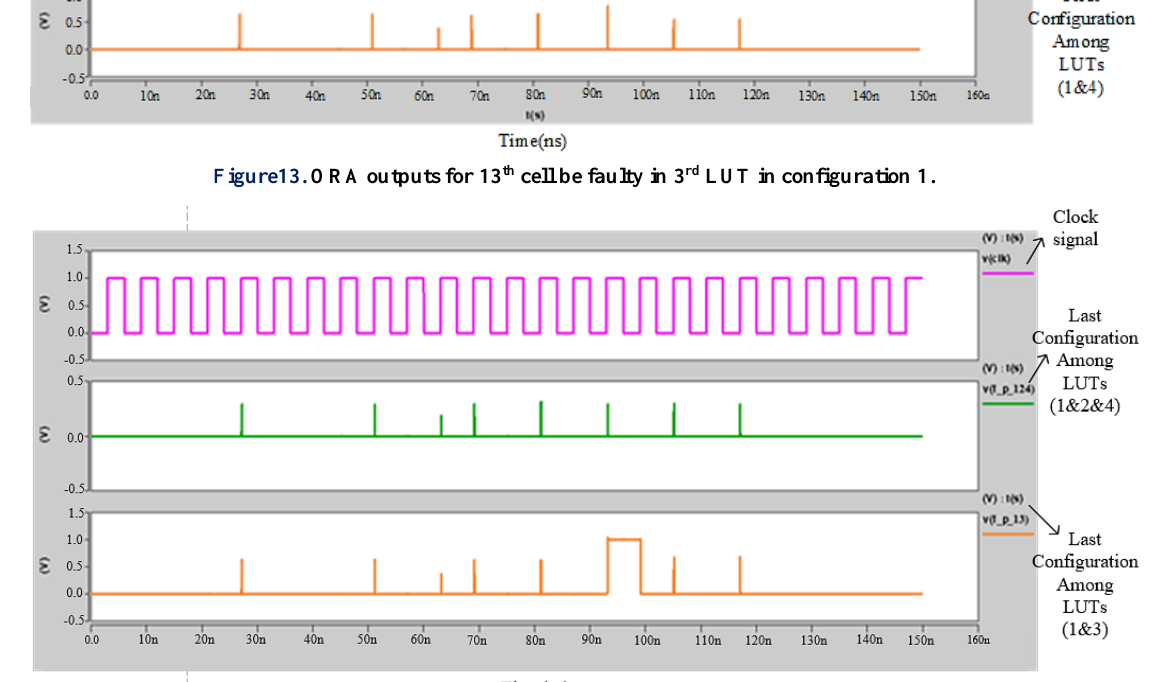
Figure14. ORA outputs for 13 th cell be faulty in 3 rd LUT in configuration